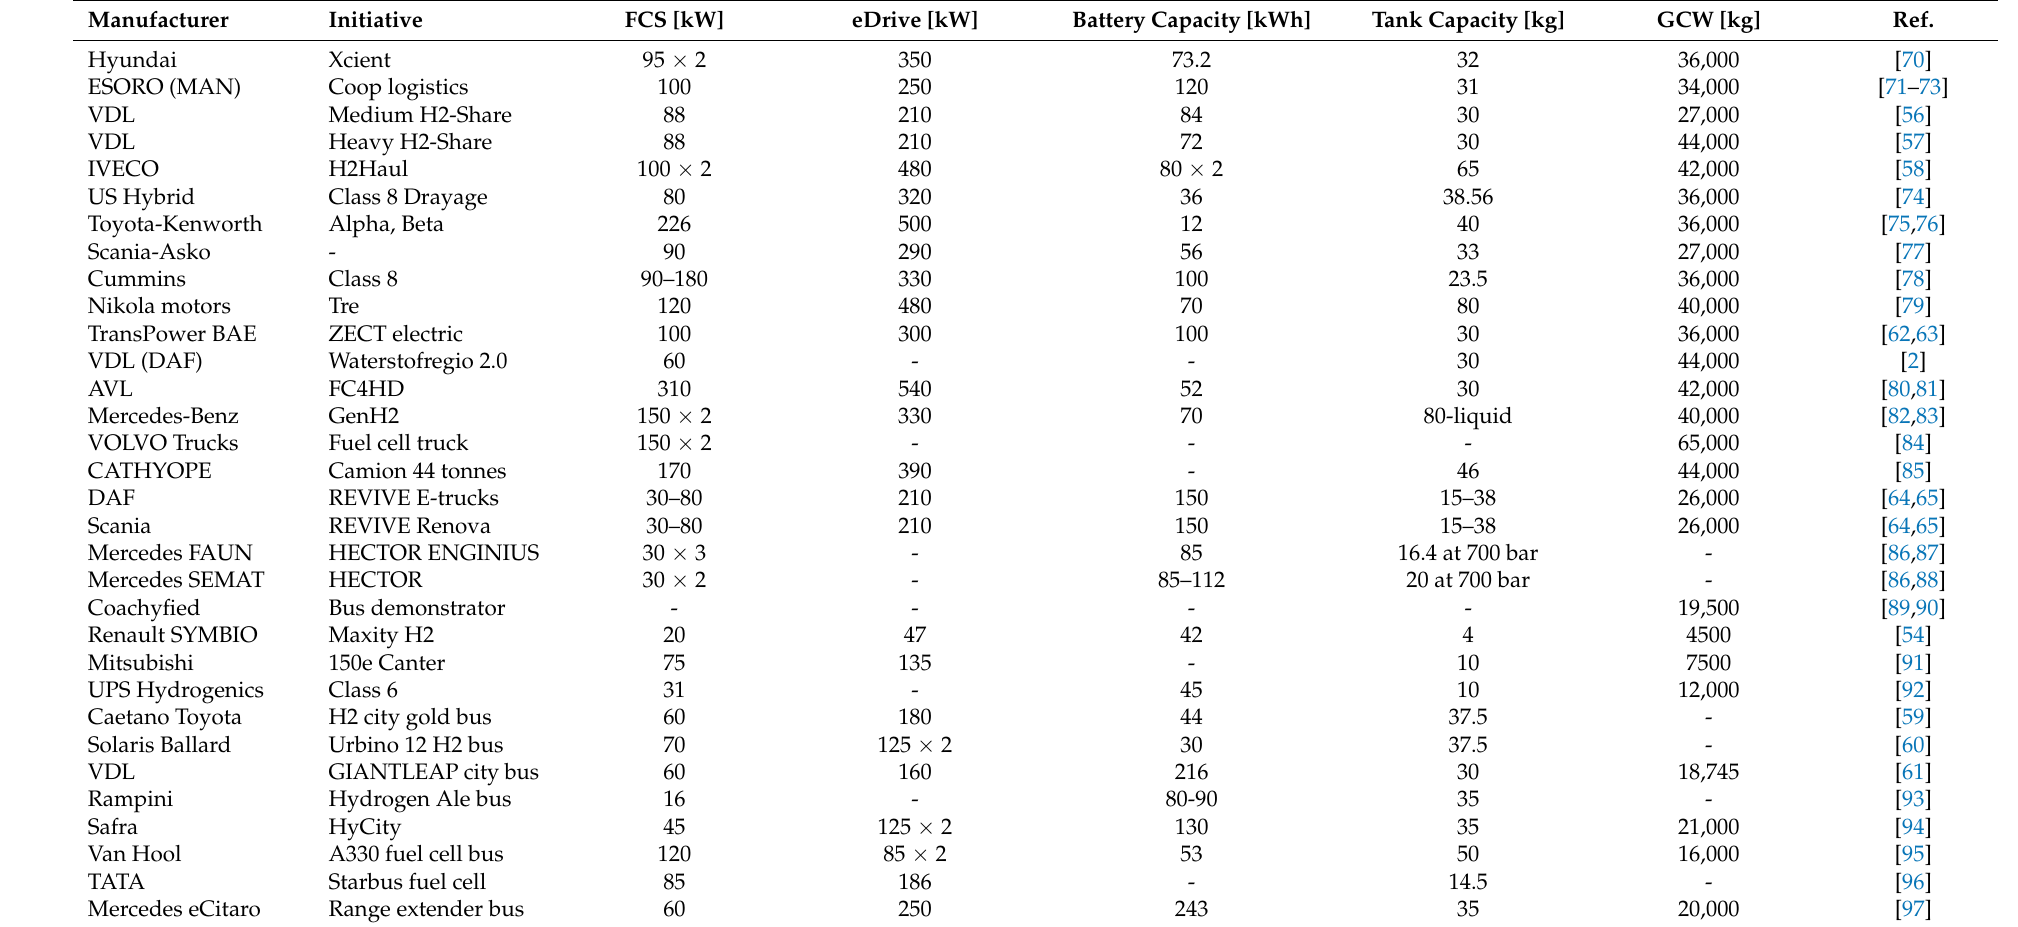
Table 1. List of current and upcoming fuel cell electric long-haul heavy-duty vehicle